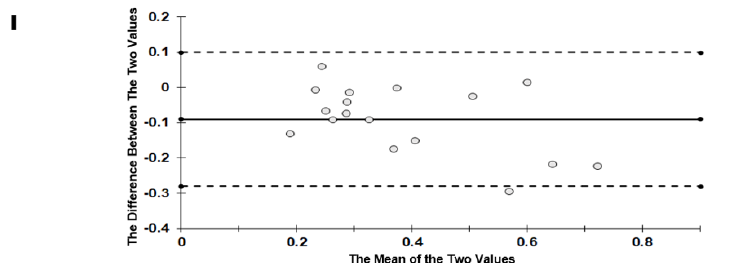
Figure 1. Acquired images from the experienced sonographer (left column, A , D , G ) and the novice sonographer (right column, B , E , H ) were analyzed by the experienced analyst (G.G.). The variables that were significantly different between sonographers during acquisition are shown: echo intensity of the vastus lateralis (top row, A , B ), cross sectional area of the medial gastrocnemius (middle row, D , E ), and subcutaneous adipose tissue thickness of the biceps brachii (bottom row, G , H ). Bland Altman plots are shown for each variable ( C , F , I ). Dotted lines: 95% limits of agreement.